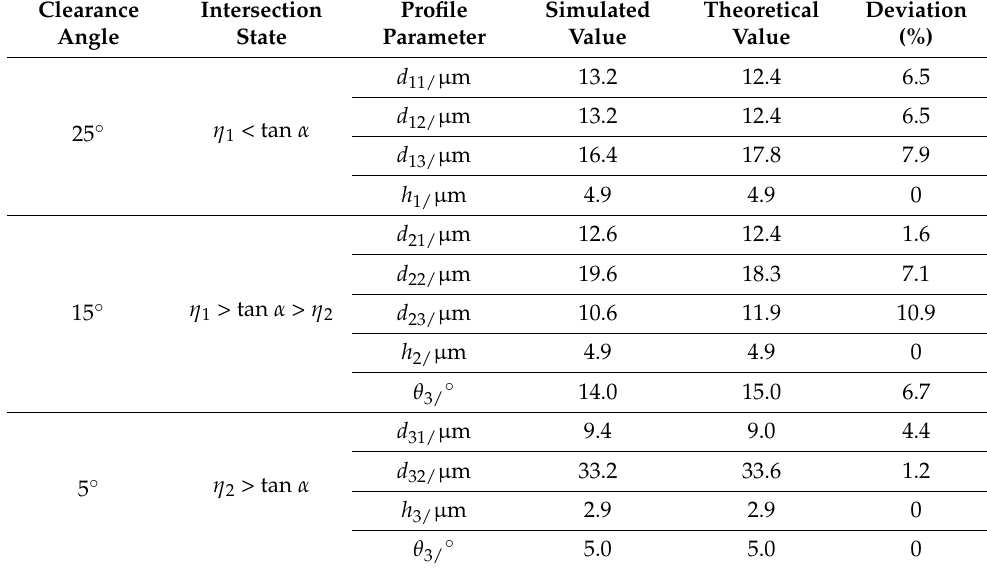
Table 1. Comparison of the simulated and theoretical values of dimple profiles under different clearance